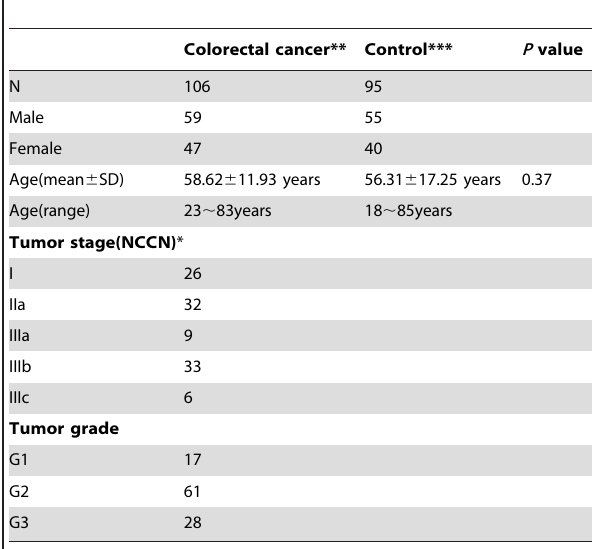
Table 1. The characteristics of participant